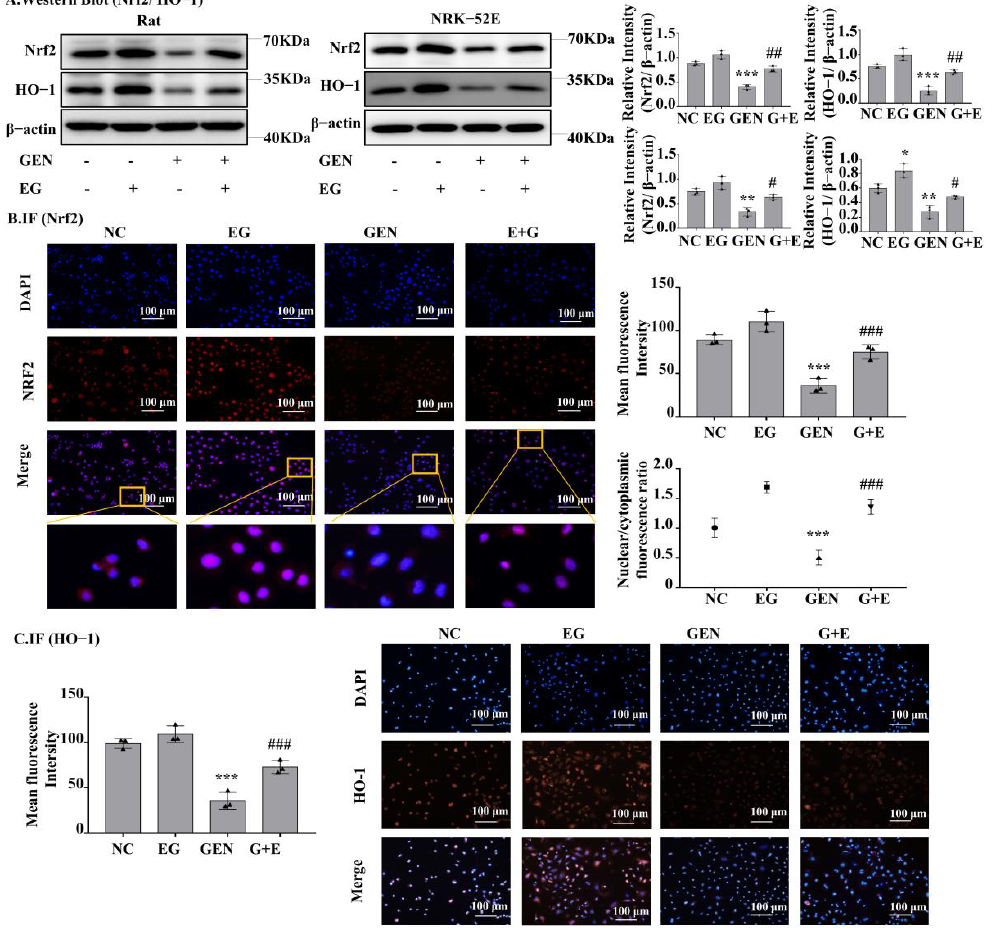
Figure 5. EG reversed GEN-induced oxidative stress in NRK-52E. ( A ) Western blot analysis of nuclear factor erythroid 2-related factor 2 (Nrf2) and heme oxygenase-1 (HO-1) in the renal cortex of SD rats and NRK-52E cells. EG (25 µ M) treatment increased the levels of Nrf2 and HO-1. ( B ) Immunofluorescence analysis of Nrf2 expression in NRK-52E cells. Scale bars = 100 µ m. ( C ) Immunofluorescence analysis of HO-1 expression in NRK-52E cells. Scale bars = 100 µ m. In vitro data was expressed as mean ± SEM of three independent experiments. * p < 0.05, ** p < 0.01, *** p < 0.001 vs. control group; # p < 0.05, ## p < 0.01, ### p < 0.001 vs. GEN group.